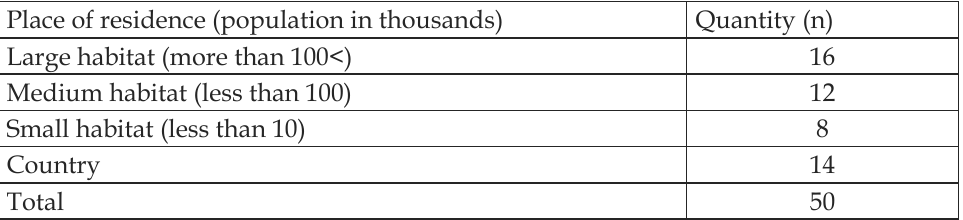
Table 5 . Distribution of places of residence in the research sample